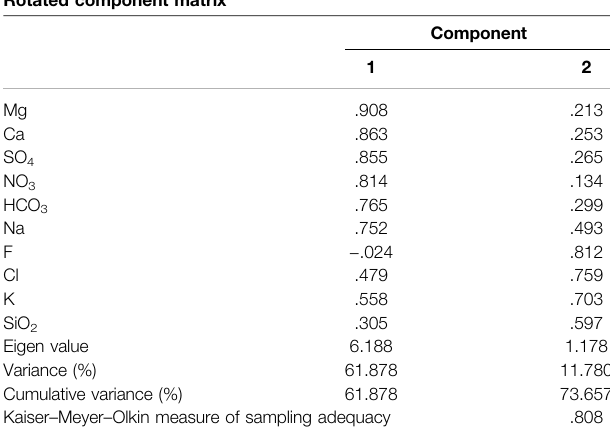
TABLE 3 | Varimax rotation PCA loading matrix. Rotated component